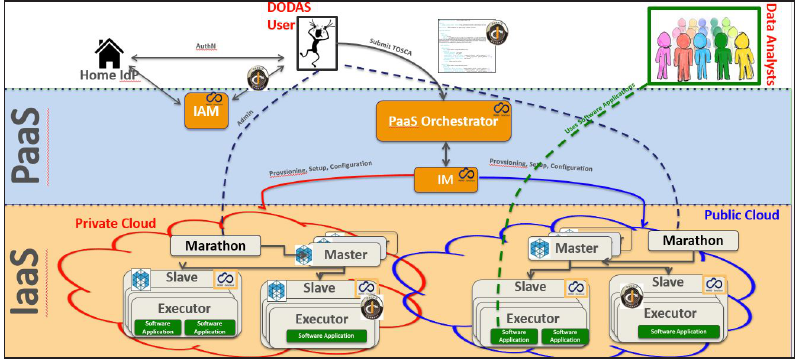
Fig. 1. A high level schema of the DODAS architecture. Three different colors identify User Domain ​ (white), DODAS PaaS core service layer (light blue), and resource layer (dark